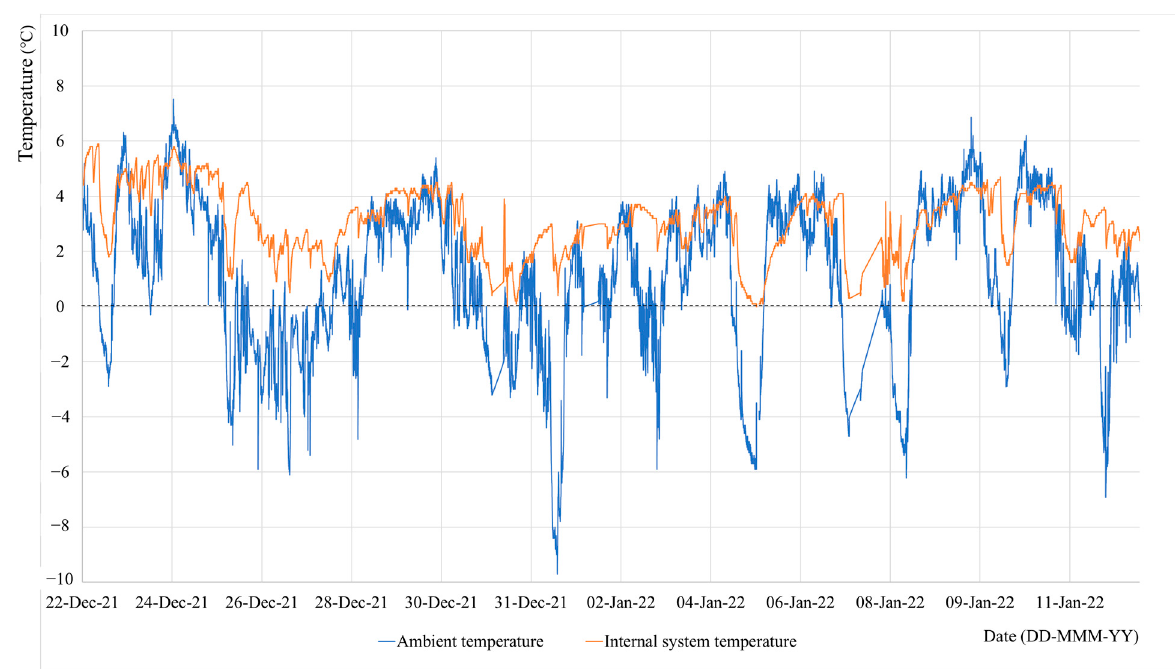
Figure 9. The recorded ambient temperature and the internal system temperature (at the field test site) over the 3-week test duration. Table 4. The maximum, minimum, and average values of the internal temperature of the system and the ambient temperature over the 3-week test duration.